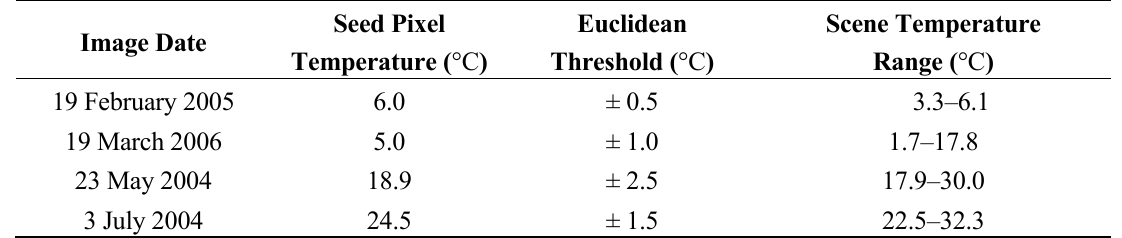
Table 2. Seed pixel temperature, threshold, and water surface temperatures in tide feature